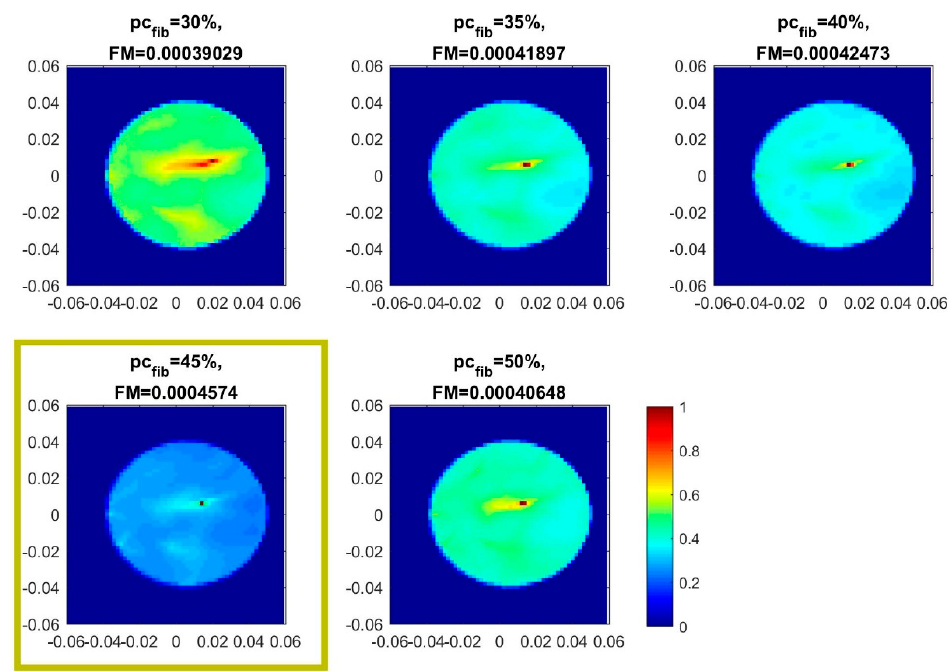
Figure 9. Example of focusing evaluation on a coronal breast slice. Parametric images generated for five assumptions in terms of percentage of fibroglandular tissue in the breast. Optimal fib pc = 45%, automatically selected based on maximization of the focusing metric (FM). Single tumor (dominant scatterer) detected on the specific breast coronal